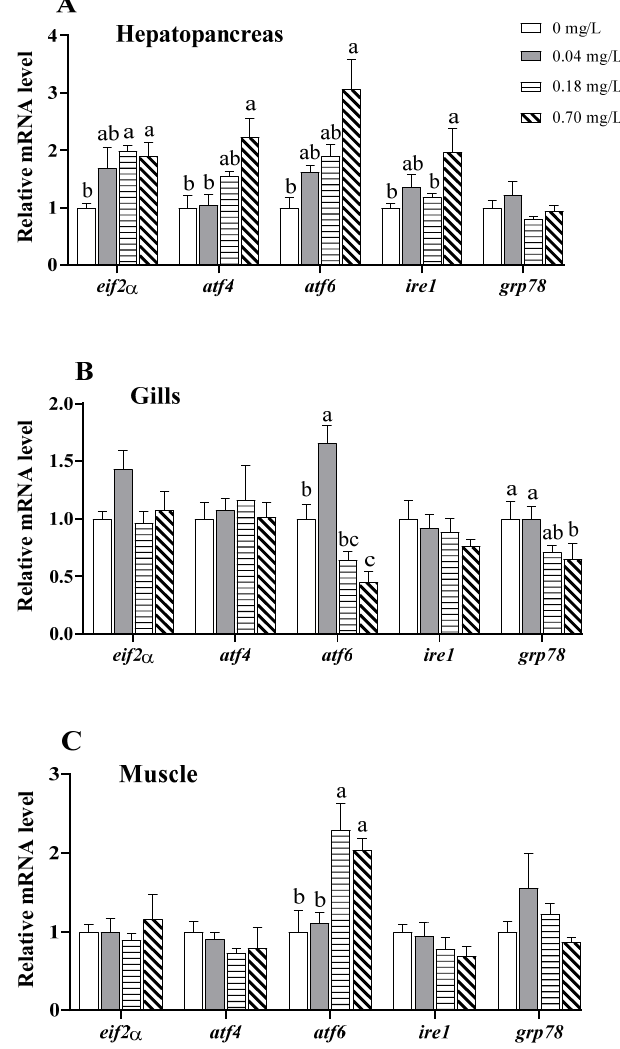
Figure 5. Expression of ER stress-related genes in different tissues of E. sinensis exposed to copper for 5 days. ( A ) Hepatopancreas; ( B ) gills; ( C ) muscle. The values are the mean ± SEM ( n = 6). Different letters denote significant differences among different groups ( p < 0.05).